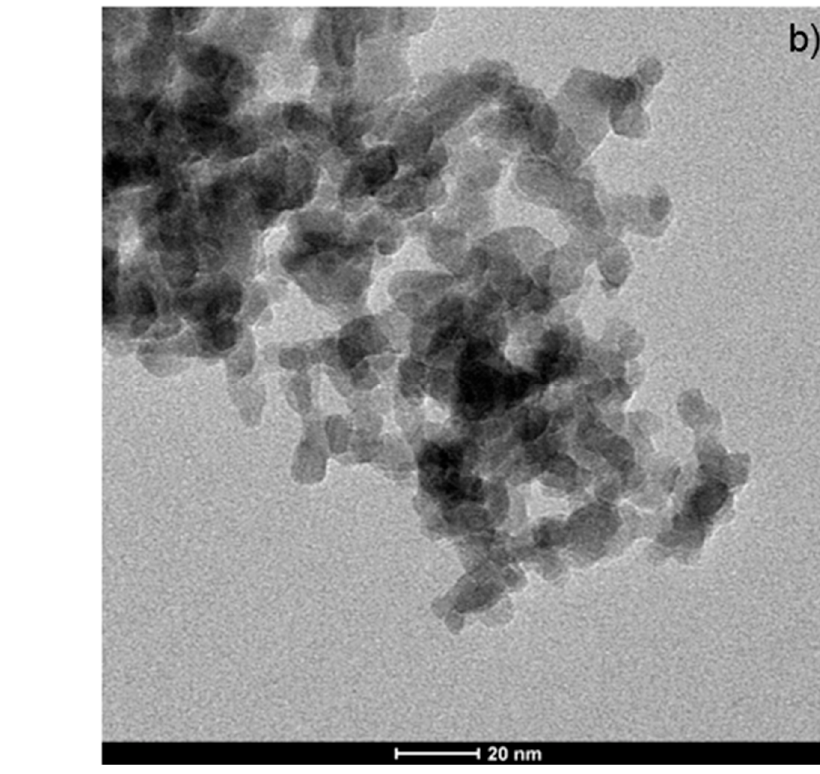
Figure 4. ( a ) The appearance of the base fluid (pure water) and the Al 2 O 3 -H 2 O nanofluid and ( b ) TEM image of the Al 2 O 3 -H 2 O nanofluid. Table 2. Properties of the Al 2 O 3 nanoparticles [43].